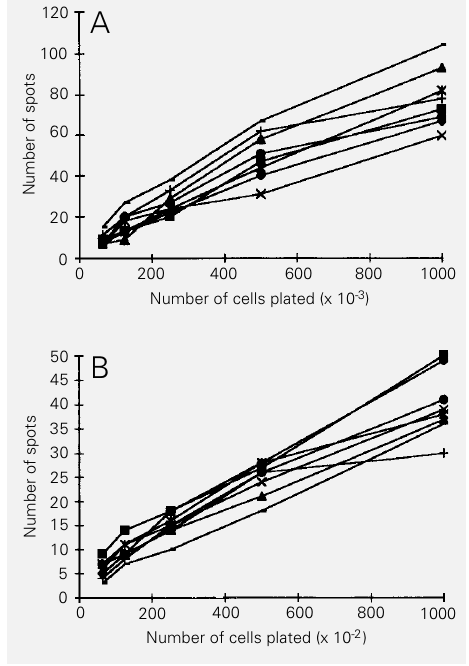
Figure 1 - Frequency of BALB/c total spleen cells secreting anti- self IgM antibodies without (A) or with (B) LPS stimulation. Note that the ordinate of panel A refers to thousands of cells plated and panel B refers to hundreds of cells plated. ¢ , Kid- ney; £ , stomach; (cid:224) , gut; 5 , heart; , spleen; + , liver; • , lung; ,